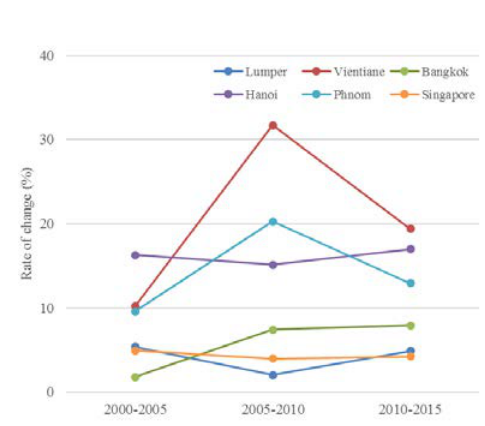
Figure 6. Expansion velocity